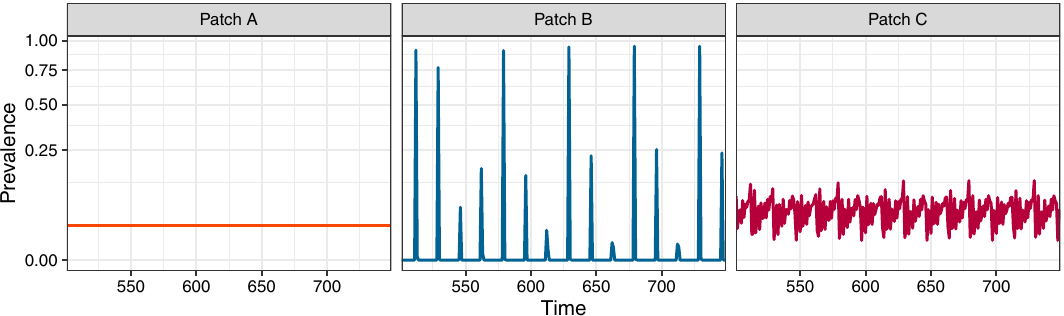
Figure 3. When multiple origin patches differ in their dynamics, the destination patch inherits oscillations over steady-states. As in Fig. 1, panels correspond to individual patches, with lines indicating the prevalence (i.e., the proportion of the patch population currently infected with the pathogen) through time. Here, we have patches A and B feeding into patch C at the same rate; A → C ← B . A and C are parametrized to produce steady-state dynamics in the absence of movement (see Methods). B shows oscillatory dynamics, with all other parameters the same. Note that, even though the parameters of C would lead to a steady-state in the absence of movement, we see oscillatory dynamics being inherited from B . Transient dynamics are omitted from the time series for